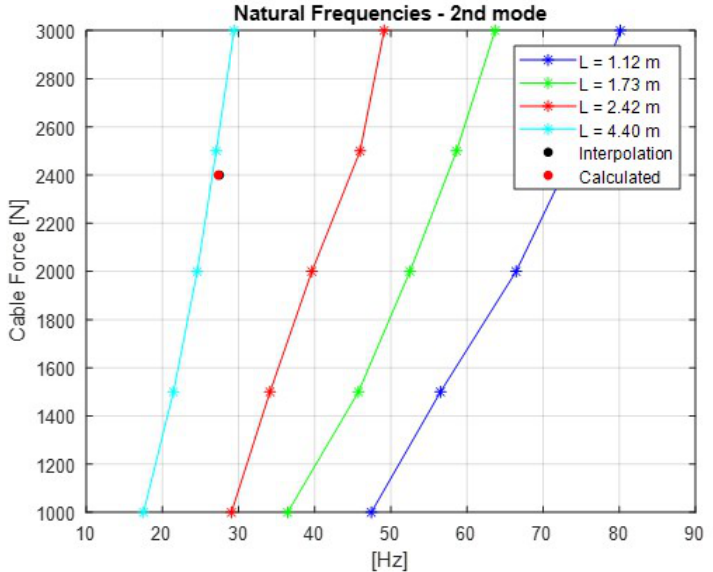
Figure 8. Relationship between the cable force and natural frequencies for the second mode of vibration.